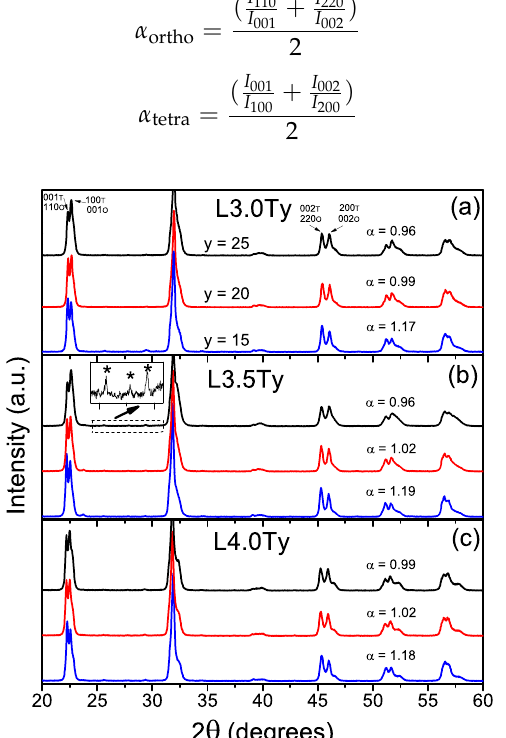
Figure 1. XRD patterns for the Li- and Ta-modified KNN materials (LKNNT) powders with compositions ( a ) L3.0Ty, ( b ) L3.5Ty and ( c ) L4.0Ty. The 001, 100, 002 and 200 peaks of the tetragonal phase were identified in ( a ) with the (T) letter, while the 110, 001, 220 and 002 peaks of the orthorhombic phase were also identified in ( a ) with the (O) letter. The peaks marked with asterisk in ( b ) were identified as belonging to the K 3 Li 2 Nb 5 O 15